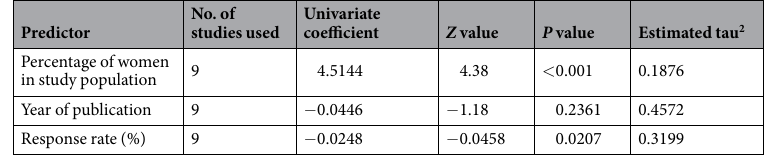
Table 2. Results for meta-regression on studies on one-year prevalence of